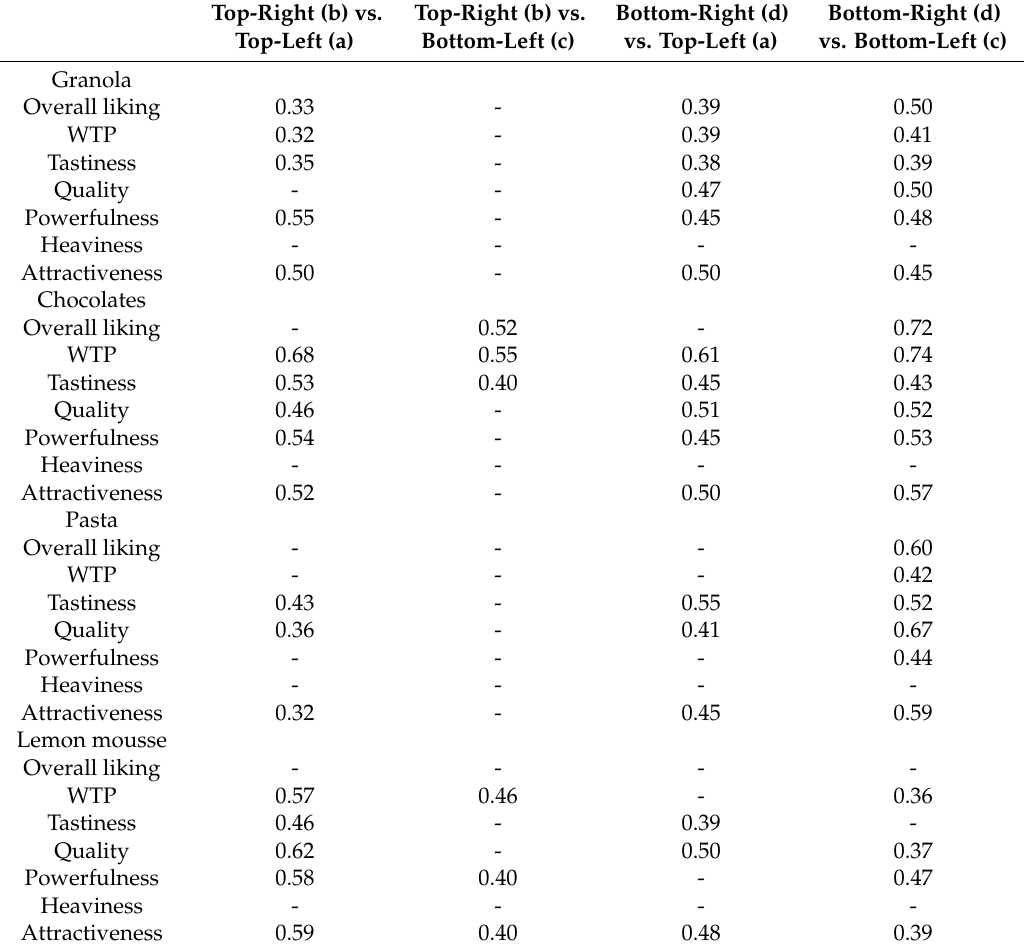
Table A1. Effect sizes for the ‘quarter-window’ (top-left/top-right/bottom-left/bottom-right) Wilcoxon signed-ranks tests by